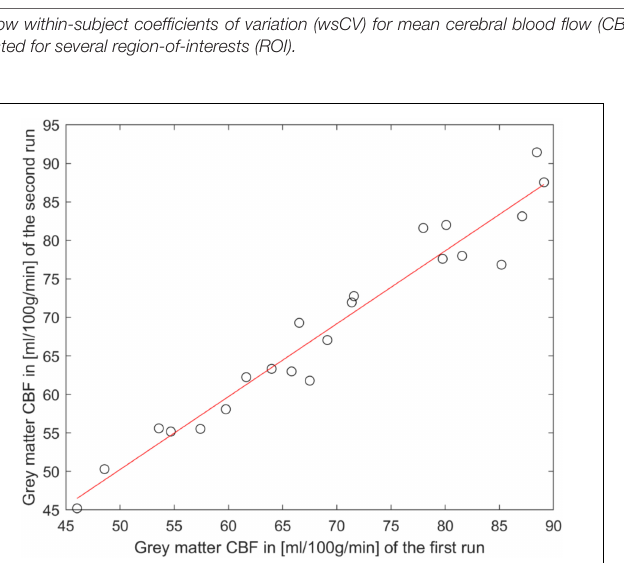
also a comparable ICC coefficient of 0.77 for white matter CBF values obtained in two sessions around six weeks apart on the same MRI system (Jann et al., 2021).